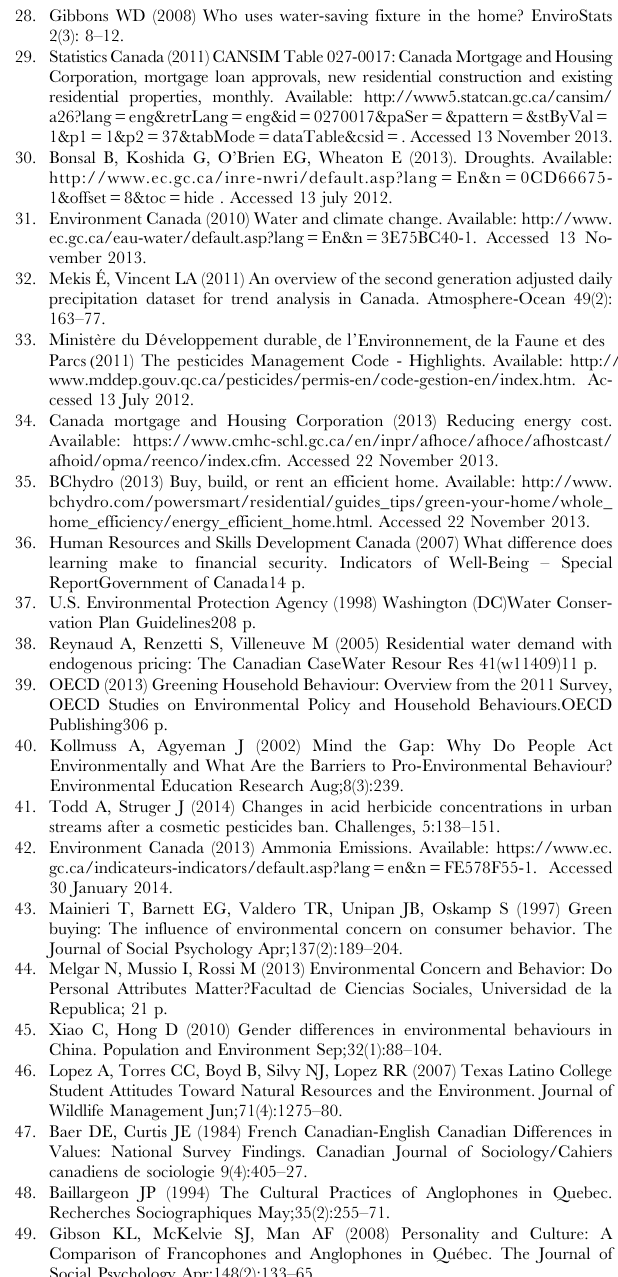
table is used. Table S4 Questions and responses selected for the Indoor Index, 2007. Table S5 Questions and responses selected for the Outdoor Index,